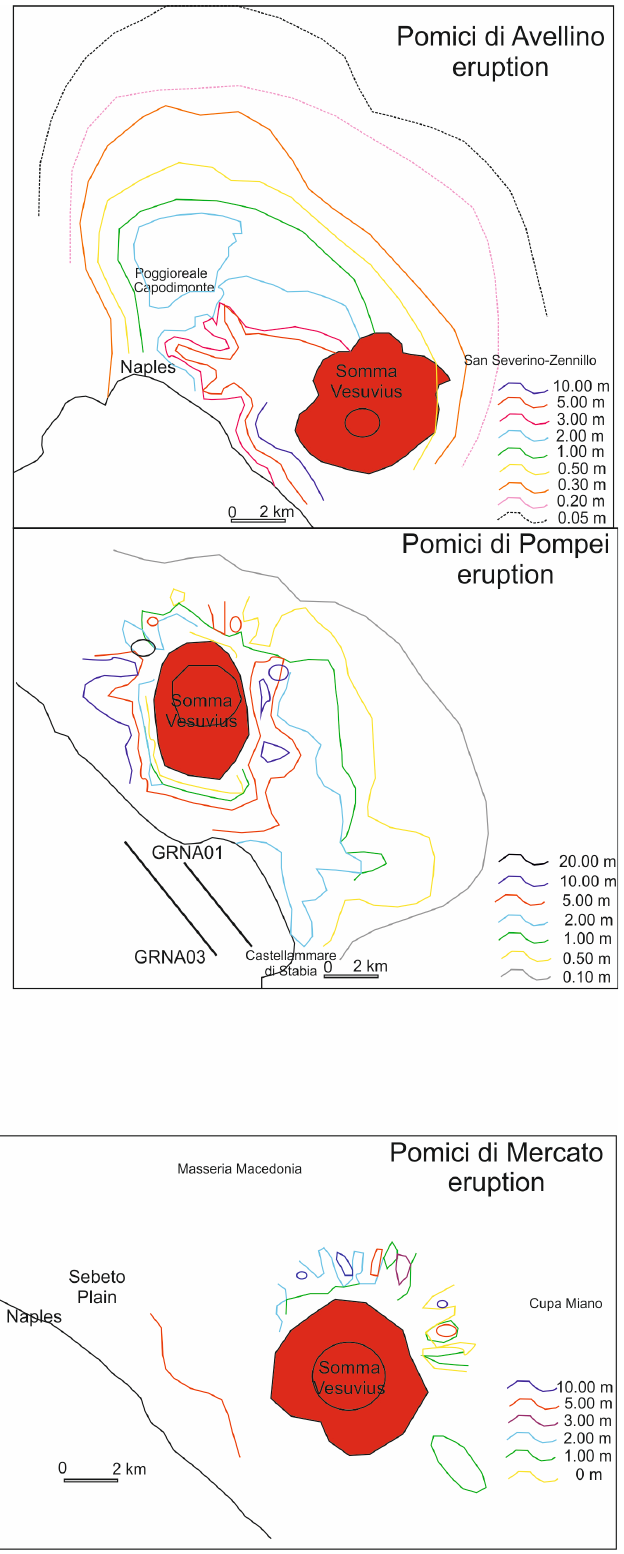
Figure 11. Isopach maps of the “Pomici di Avellino”, “Pompei Pumice”, and “Pomici di Mercato” eruptions (after [25]). These maps were used as geological constraints in order to support the interpretation of the G seismic unit as the PDCs older than the AD 79 eruption. The location of the GRNA01 and GRNA03 seismic profiles (Figure 6) is also shown.